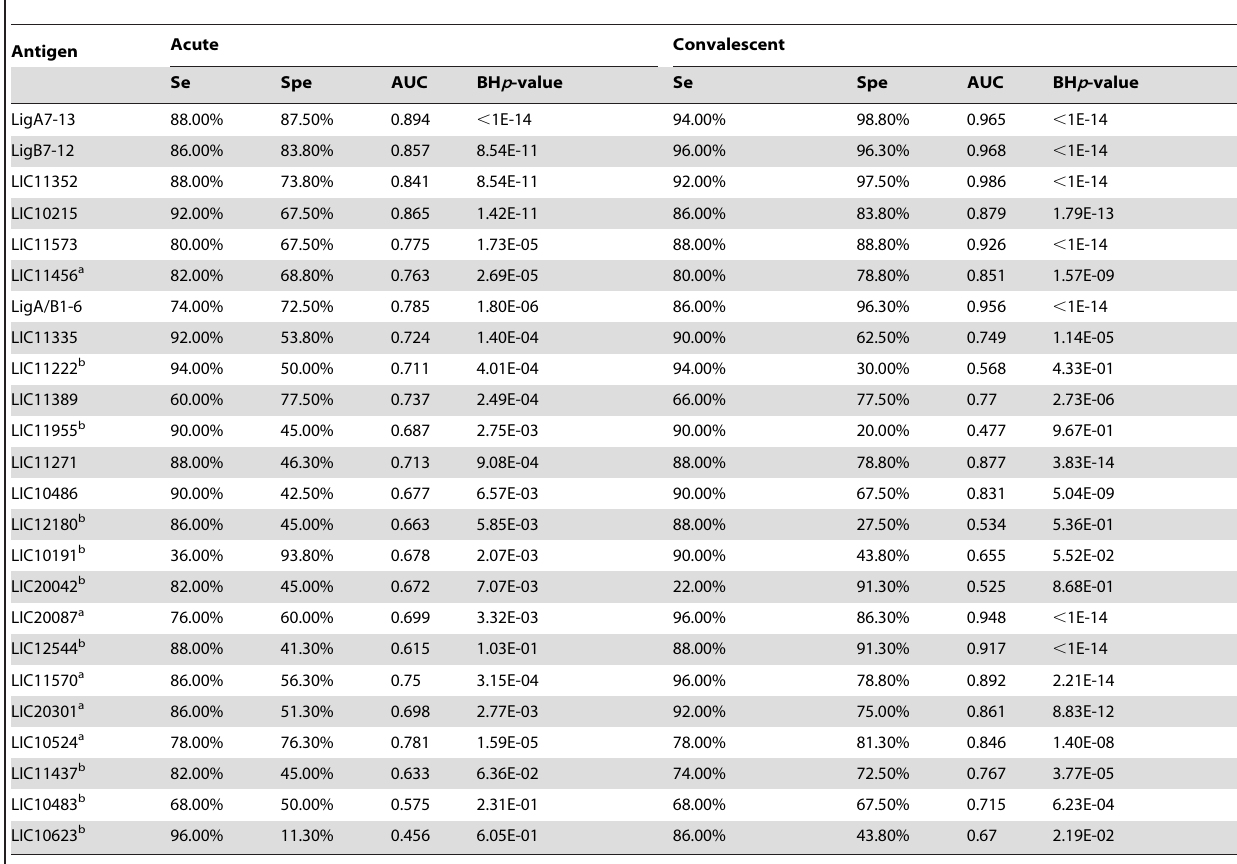
Table 2. Accuracy of the differentially reactive antigens for both acute- and convalescent-phase patients after array probing.